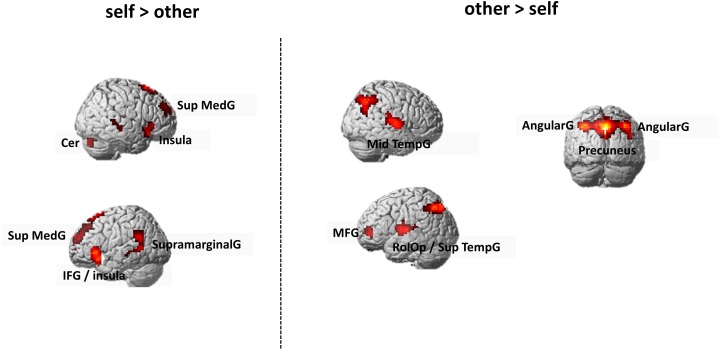
Whole Brain activation in the contrast self > other (left side) and other > self (right side). FWE-correction (p < 0.05). AngularG, angular gyrus; Cer, cerebellum, IFG, inferior frontal gyrus; MFG, middle frontal gyrus; Mid TempG, middle temporal gyrus; RolOp, rolandic operculum; SupramarginalG, supramarginal gyrus; Sup MedG, superior medial gyrus; Sup TempG, superior temporal gyrus.